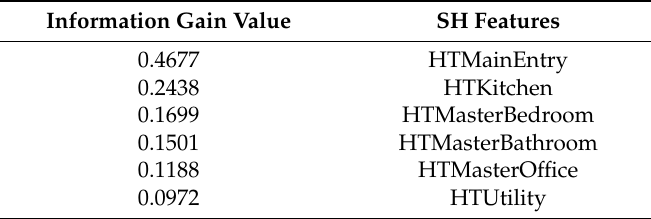
Table 15. InfoGain method predictions for outdoor PM 2.5 in IAQ 2 .